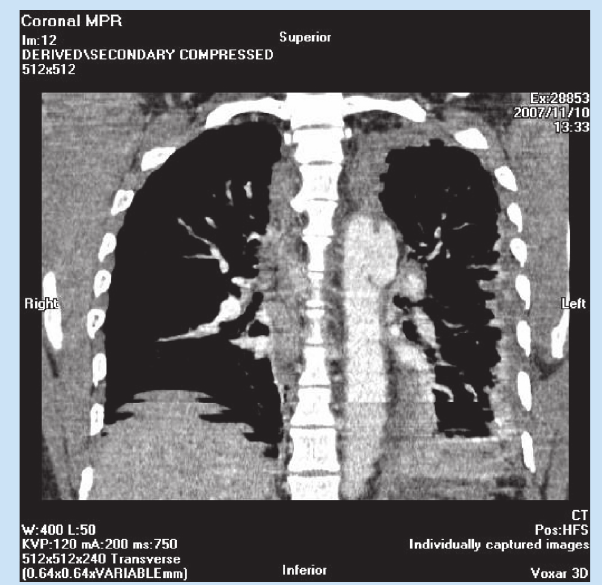
Fig. 2. Post-contrast chest CTA (coronal view), demonstrating the pseudo-aneurysm in the distal aortic arch.